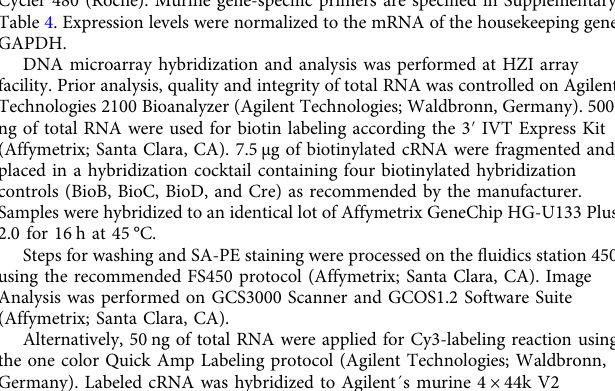
Table 4. Expression levels were normalized to the mRNA of the housekeeping gene